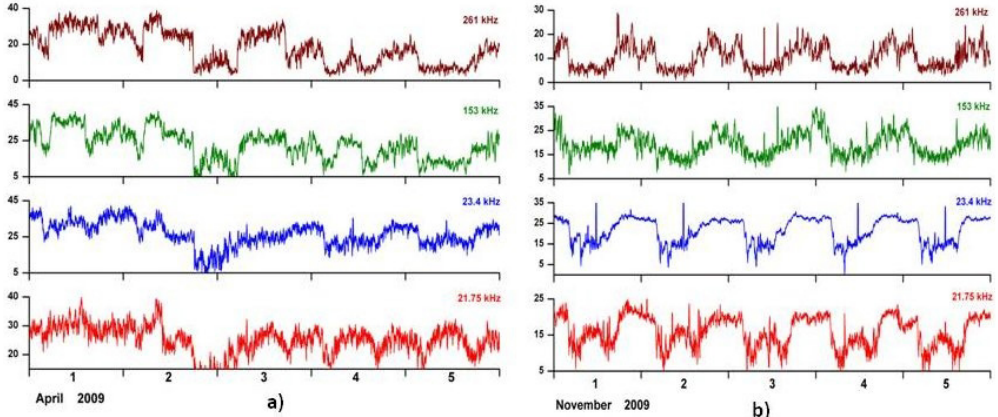
Fig. 4. (a) Trend of the intensity of four VLF/LF radio signals sampled in Sivas (eastern Turkey) during five days. All the signals appear disturbed and irregular. (b) Trend of the intensity of the same radio signals sampled in Resadiye (eastern Turkey) during five days. The reception of the different signals is good enough and